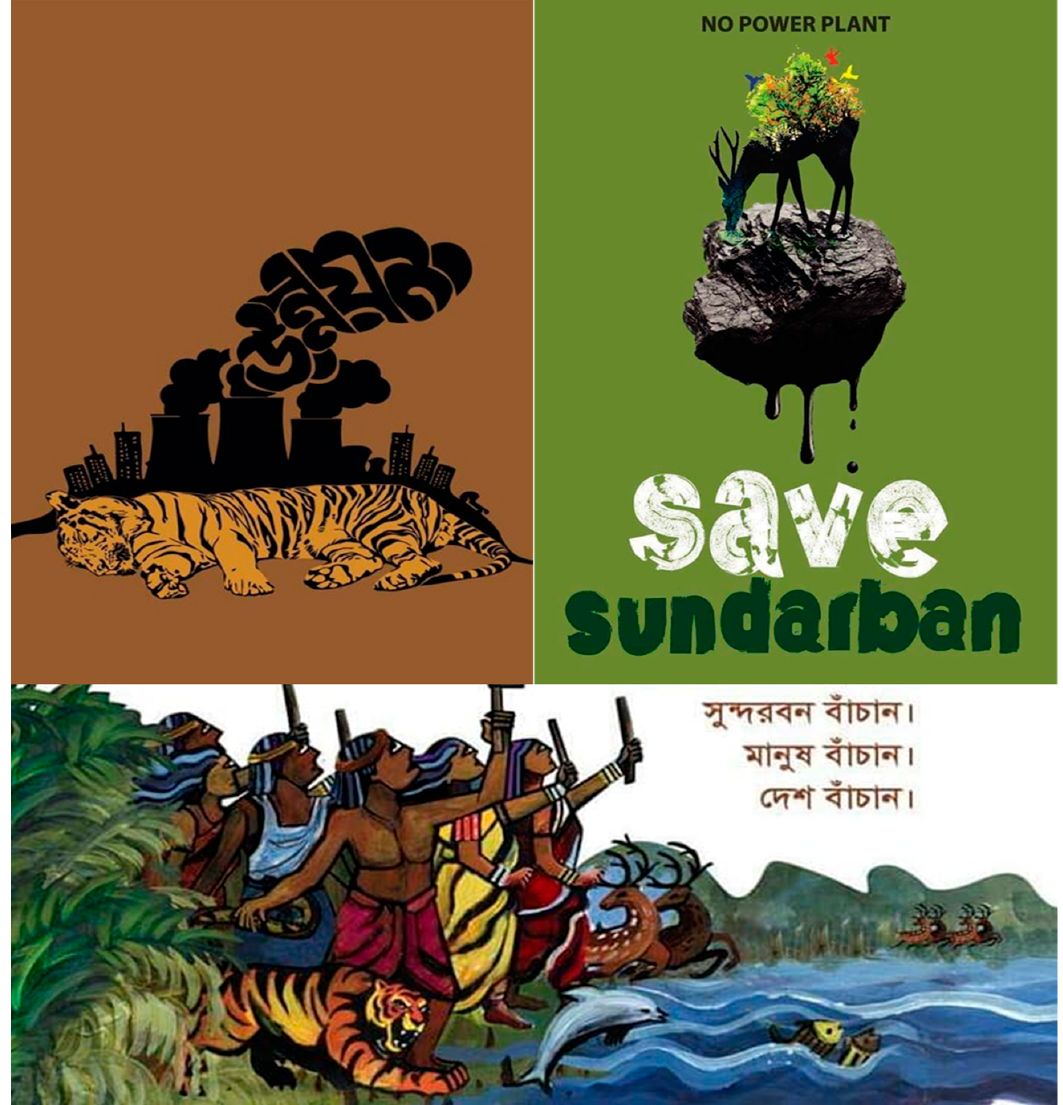
Figure 3. Posters used in Sundarban Anti-Rampal Movement (Source: Reference [82]).